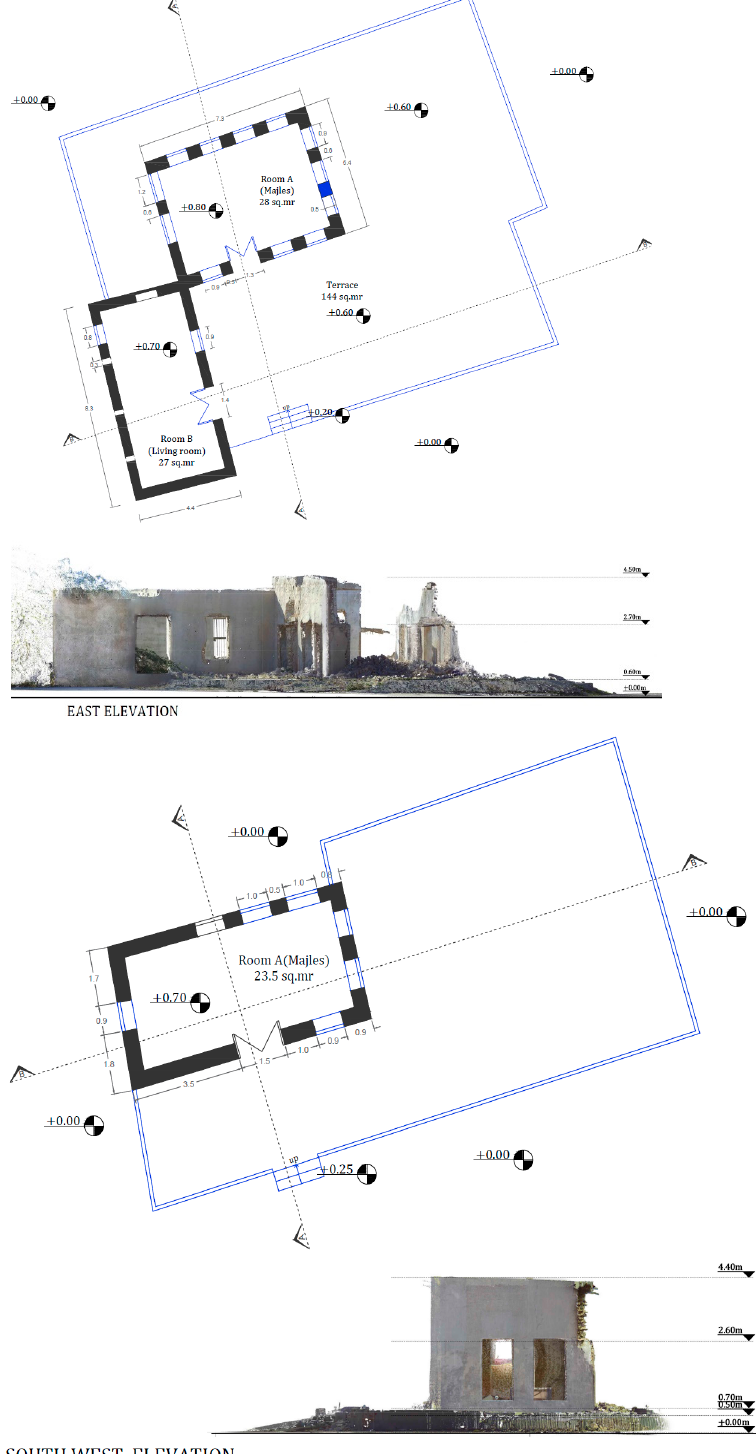
Figure 15. Two plans of two Majales with their facades: building 2 on the right and building 3 on the left. Notice the excessive use of windows in the main hall of both majales. The drawing is a result of 3D scanning by the authors.